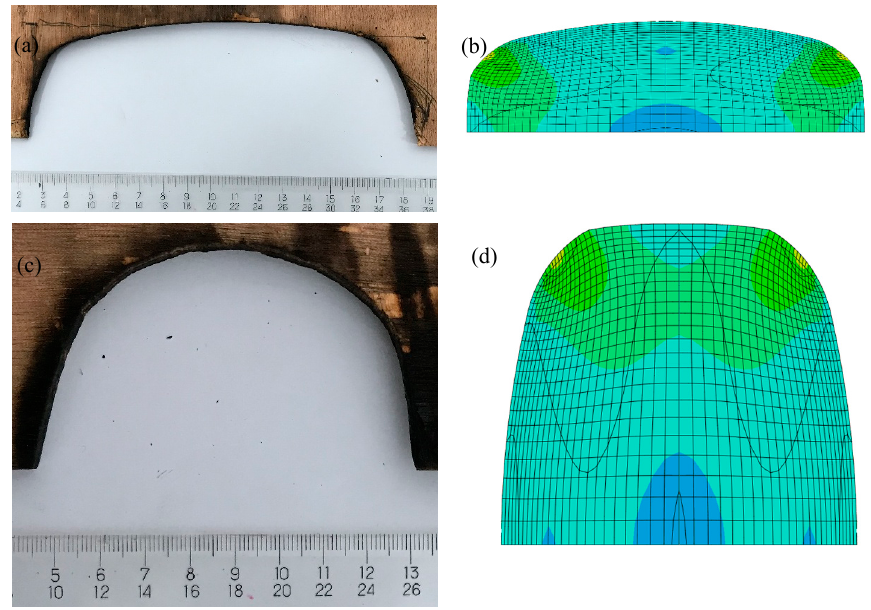
Figure 5. Comparison of experimental and simulated billet geometry at the exit of the third pass: ( a ) The top surface of the experimental billet geometry. ( b ) The top surface of the simulated billet geometry. ( c ) The lateral surface of the experimental billet geometry. ( d ) The lateral surface of the simulated billet geometry.